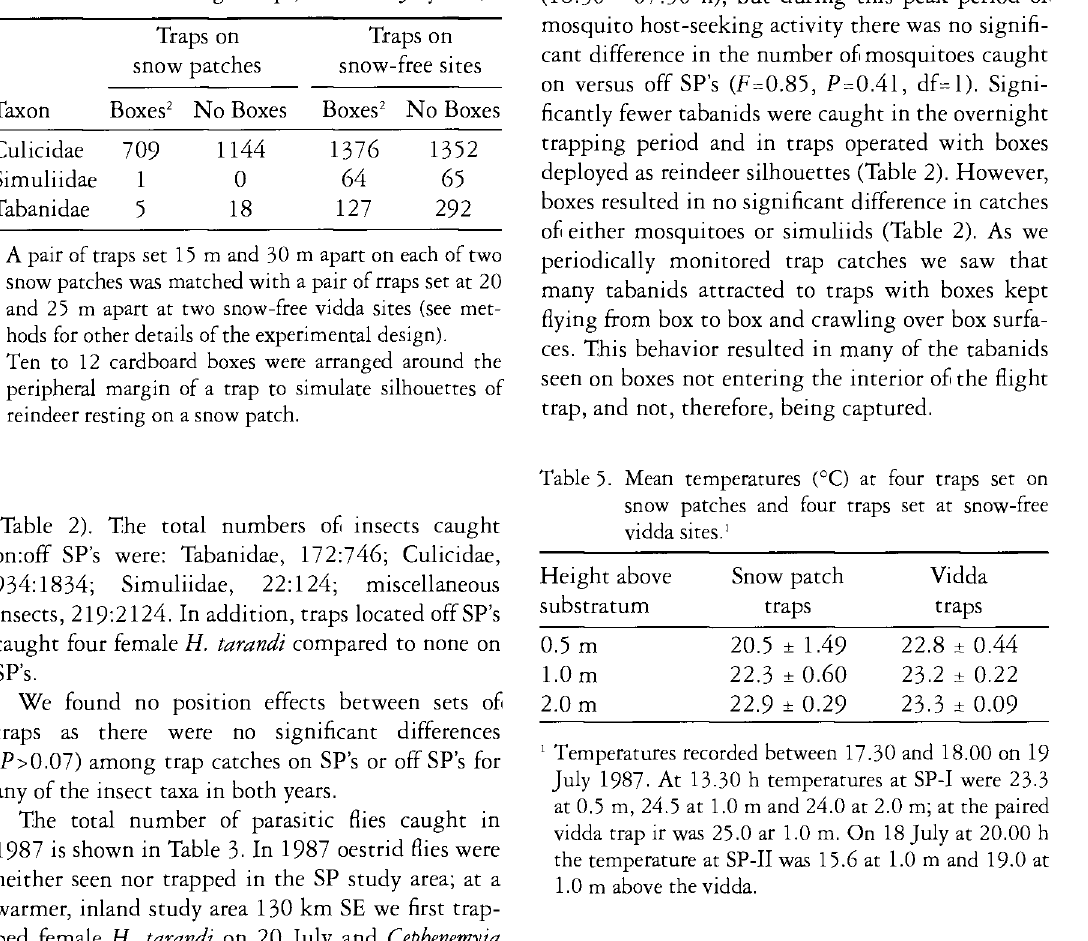
Table 3. Total numbers of parasitic flies caughr in C0 baited insect flight traps, 18 and 19 July 1987 1 .